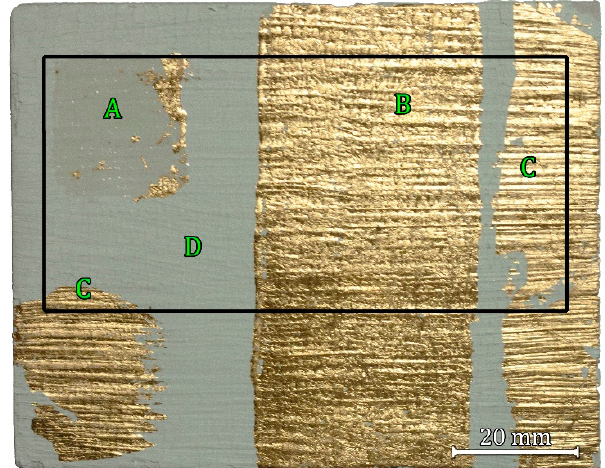
Figure 1. Gilded sample. Regions represent the gilding glue on substrate ( A ), gold leaf applied on gilding glue ( B ), gold leaf applied on substrate ( C ) and substrate ( D ). Black rectangle represents the Macro-X-ray fluorescence (MA-XRF) scanned area.